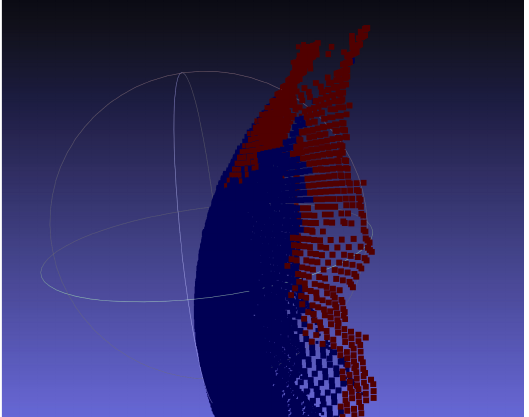
Figure 20. Close-up of the sphere of experiment 1 already adjusted by removing outliers with the Z-score, Visualization in Meshlab.